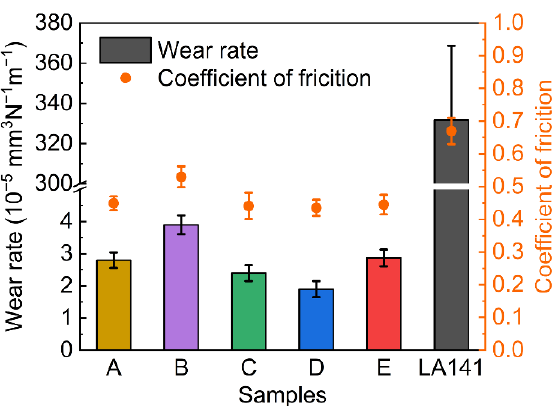
Figure 6. Wear rate and friction coefficient of Fe-based AMCs and LA141 magnesium alloy.